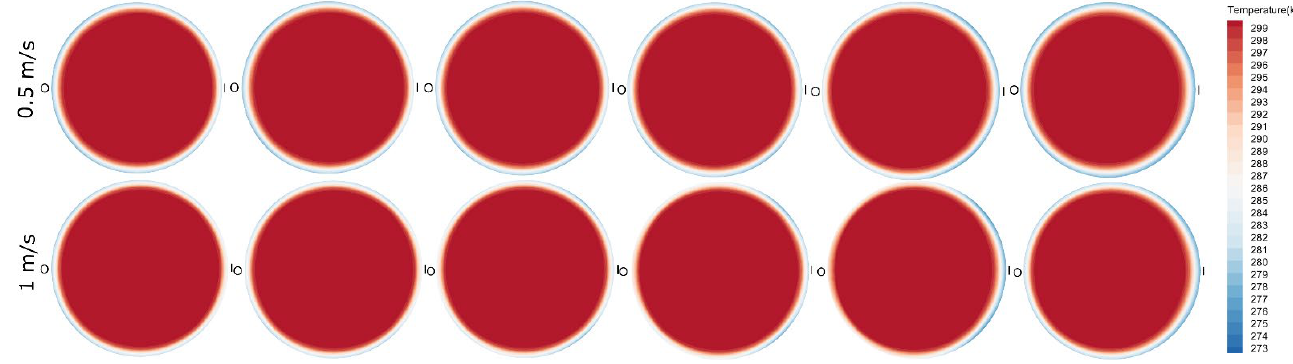
Figure 6. Temperature distributions on the five sections and the outlet plane of the U-shaped channel. From the left to the right, the order of these sections is from the inlet to the outlet of the channel. The upper row shows the data at the inlet velocity of 0.5 m/s at the temperature conditions of 273 K on the wall and 300 K of the incoming fluid at the inlet. The lower row shows the data at the inlet velocity of 1 m/s at the temperature conditions of 273 K on the wall and 300 K of the incoming fluid at the inlet.